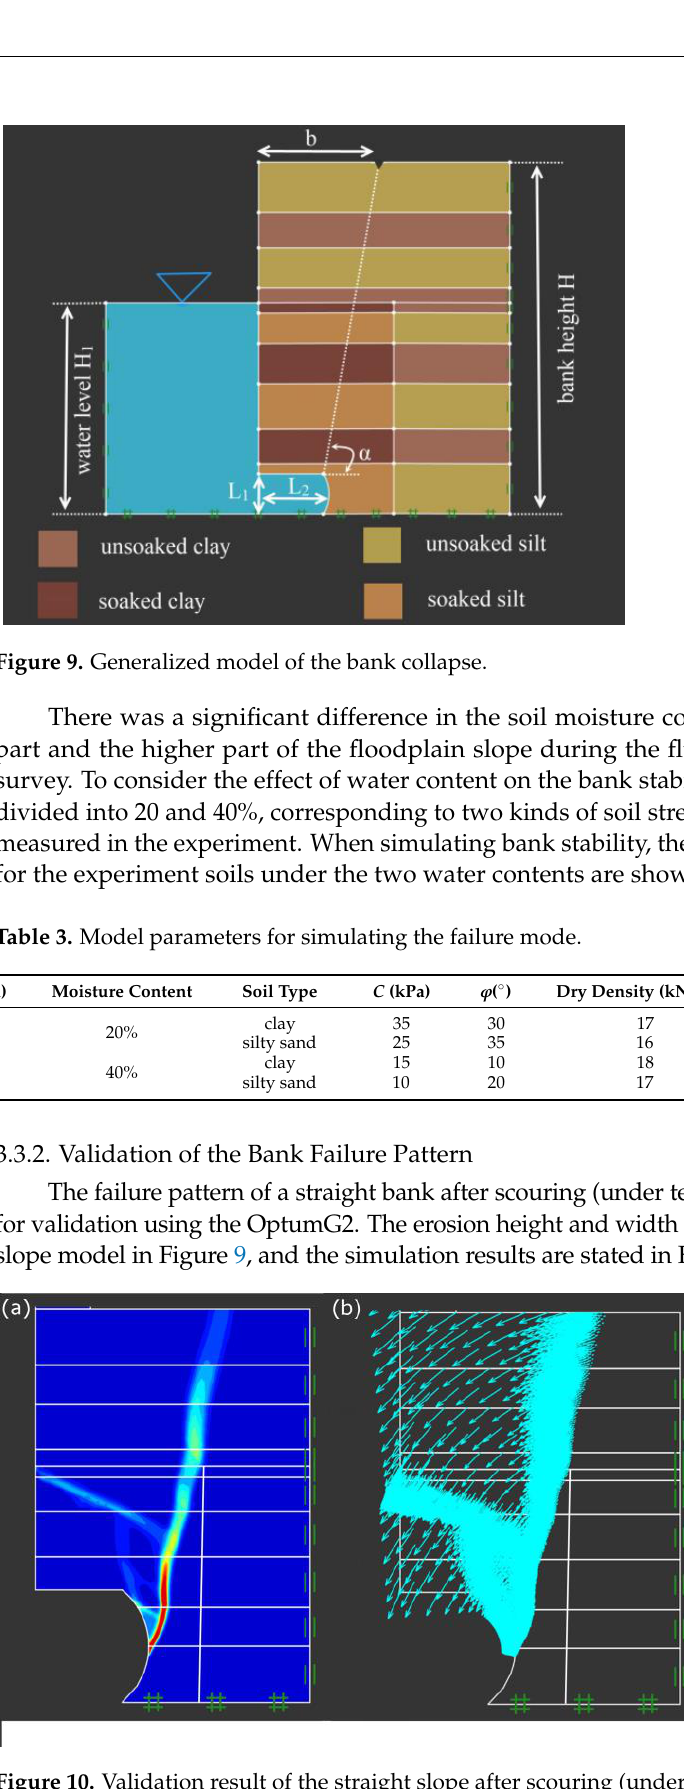
Figure 10. Validation result of the straight slope after scouring (under working condition 5): ( a ) the bank failure surface; and ( b ) displacement vector map.